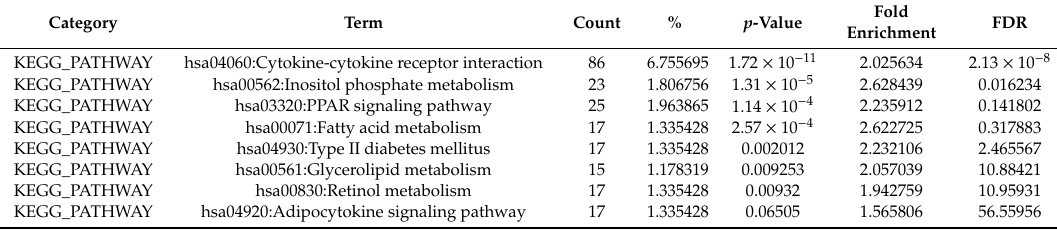
Table 4. Kyoto Encyclopedia of Genes and Genomes (KEGG) pathway enrichment analyses of DE miRNA gene targets associated with lipid and fatty acid metabolism, and fat